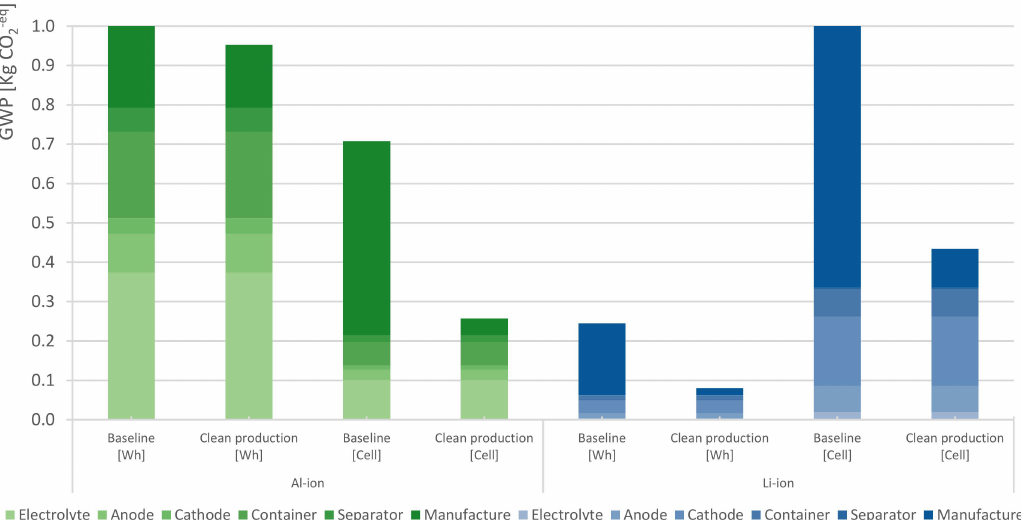
Figure 5. 18650-cell’s sensitivity analysis. The baseline scenarios are based on the current environmental contribution of each chemistry for the corresponding functional unit. The clean production scenario assumes that the source of the energy used in the manufacturing phase is solar photovoltaic (PV). According to the simulation, Li-ion cells can cut 67% of their carbon footprint, while the Al-ion battery could reduce 64% of their GWP